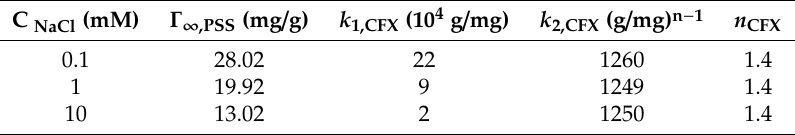
Table 2. Fit parameters for the adsorption isotherms of CFX onto PSS-modified Al 2 O 3 (PMA) at di ff erent NaCl concentrations (pH 6). The maximum adsorbed amount is Γ ∞ , PSS , the equilibrium constants are k 1,CFX , k 2,CFX for first layer and multilayer, respectively, n the number of clusters of CFX molecules. C NaCl (mM)